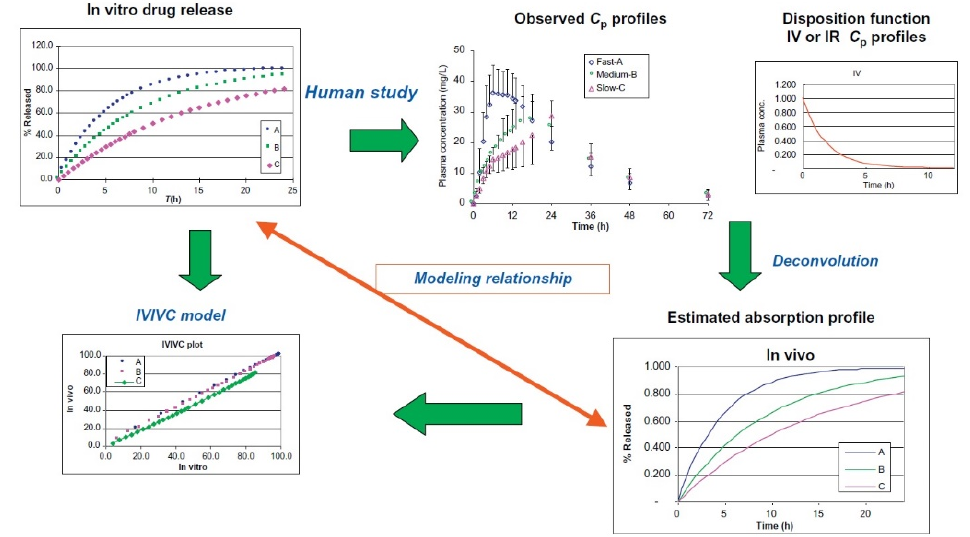
Figure 13. Illustration of convolution and deconvolution in IVIVC development, Reproduced with permission from [100]. Reproduced with permission from Y. Qiu, J.Z. Duan, Developing Solid Oral Dosage Forms; published by Elsevier, 2017.